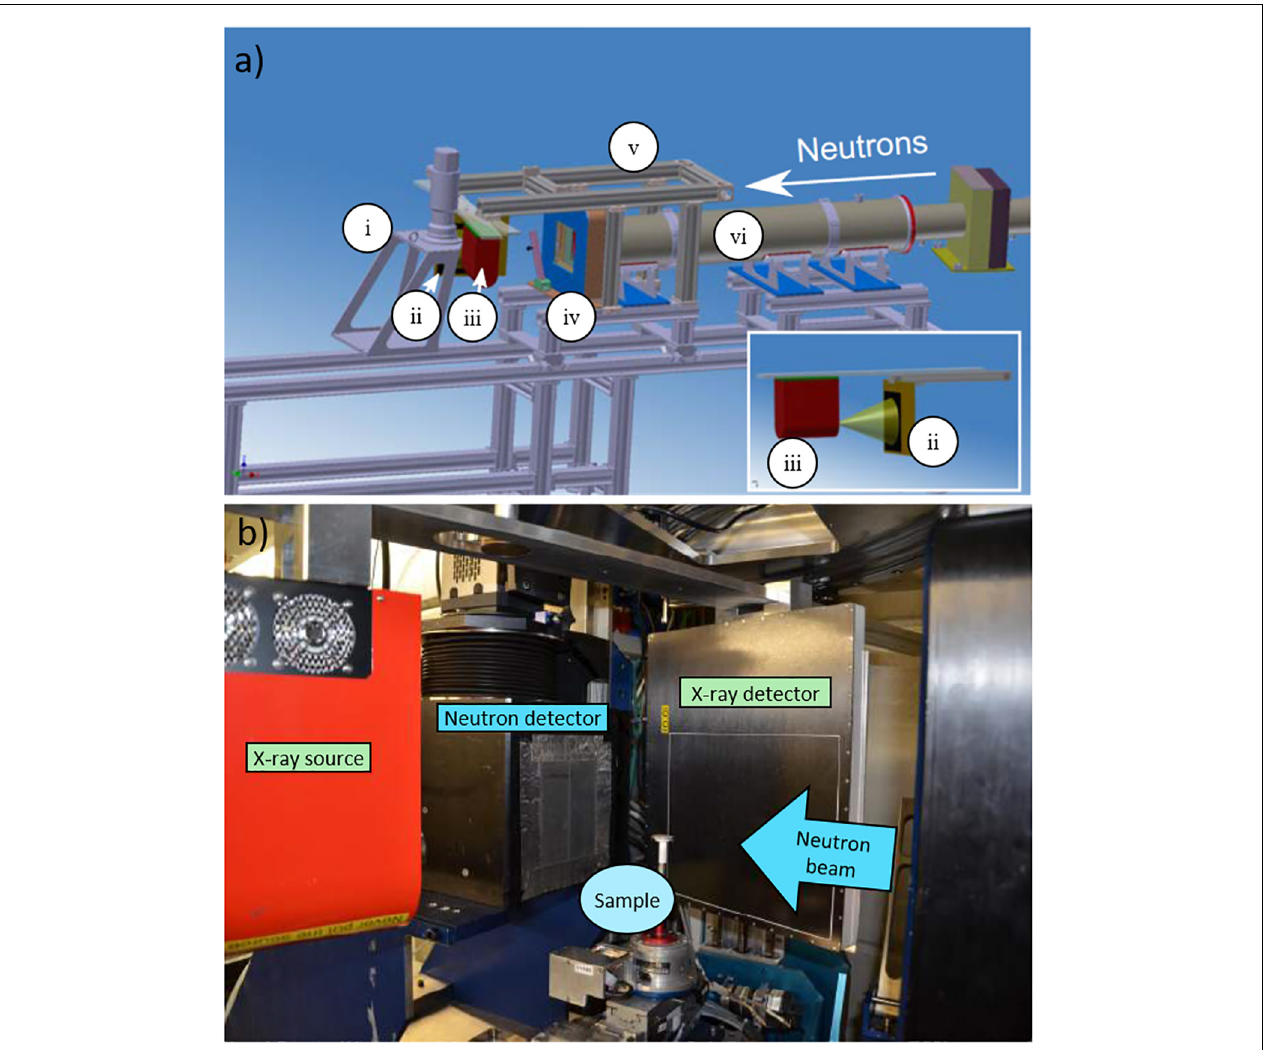
FIGURE 2 | Experimental setup. (a ) A view showing the arrangement of the neutron source and detector and also the X-ray source and detector used for bimodal imaging (Kaestner et al., 2017). In detail, (i) Neutron camera detector, (ii) Flat panel detector, (iii) X-ray source, (iv) Neutron beam limiter, (v) Frame for X-ray beamline, and (vi) Neutron flight tubes. (b) A photograph showing the arrangement that was used for neutron and X-ray imaging (Kaestner et al., 2016).